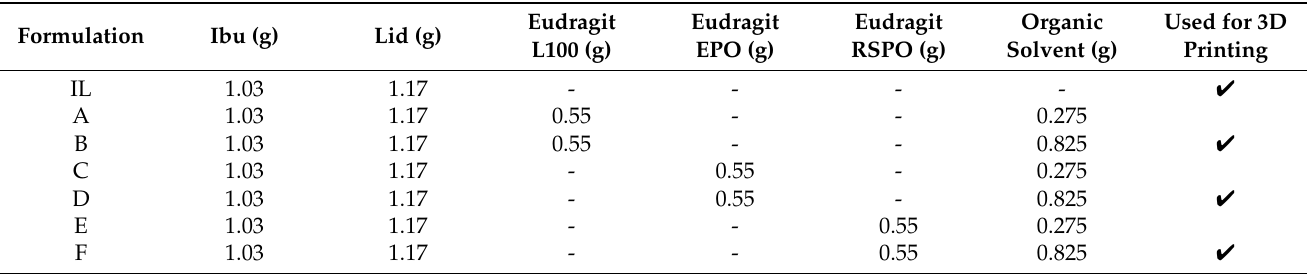
Table 1. Compositions of ink formulations for 3D